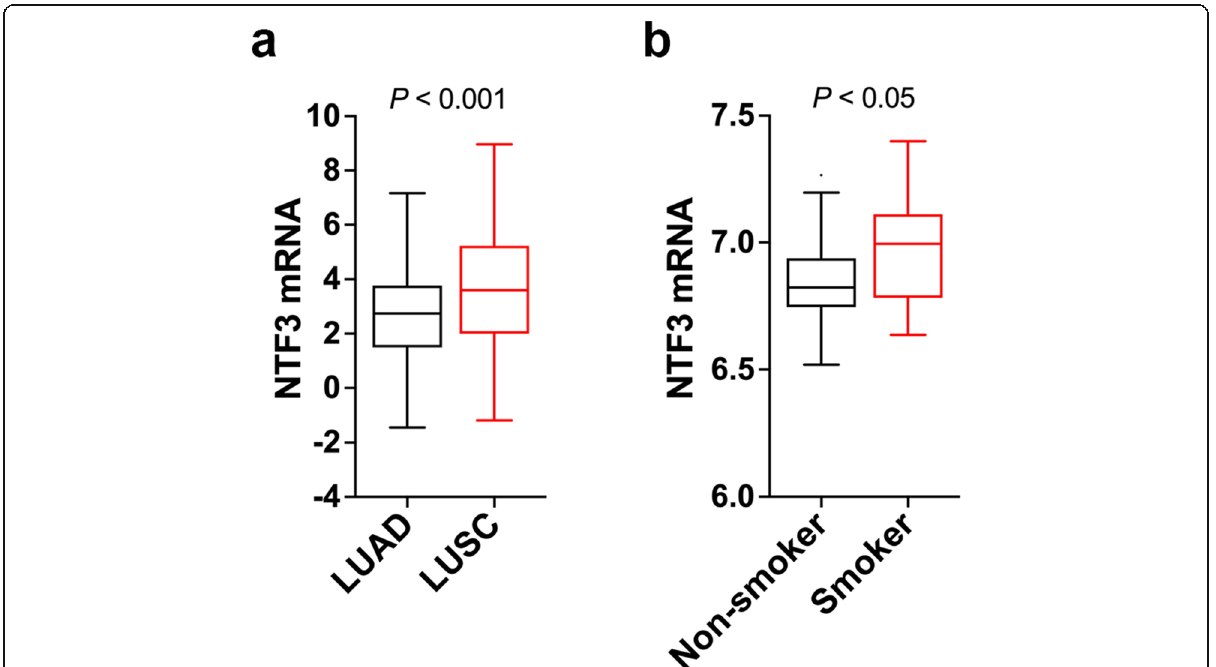
Fig. 5 NTF3 levels are increased in LUSC tumors and bronchial airways of smokers. (a) Tumor NTF3 levels, LUAD versus LUSC. The dataset is normalized, log2 RNA-sequencing data from TCGA. Number (n) of patient specimens per group: 250 LUAD, 284 LUSC. (b) NTF3 levels in a non- cancer cohort comparing bronchial brushings from smokers (n = 16) and healthy controls (n = 28). The dataset is normalized, log2 gene